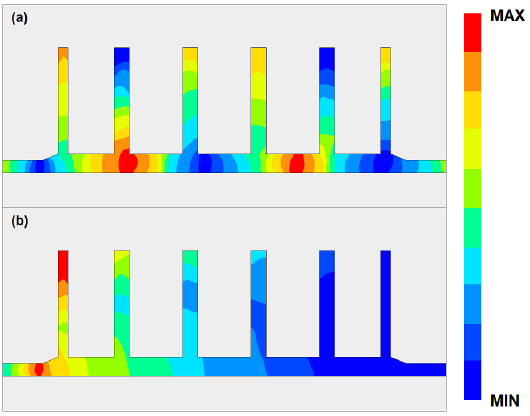
Figure 8. The field distribution of the SSPP structure at ( a ) passband and ( b ) stopband.